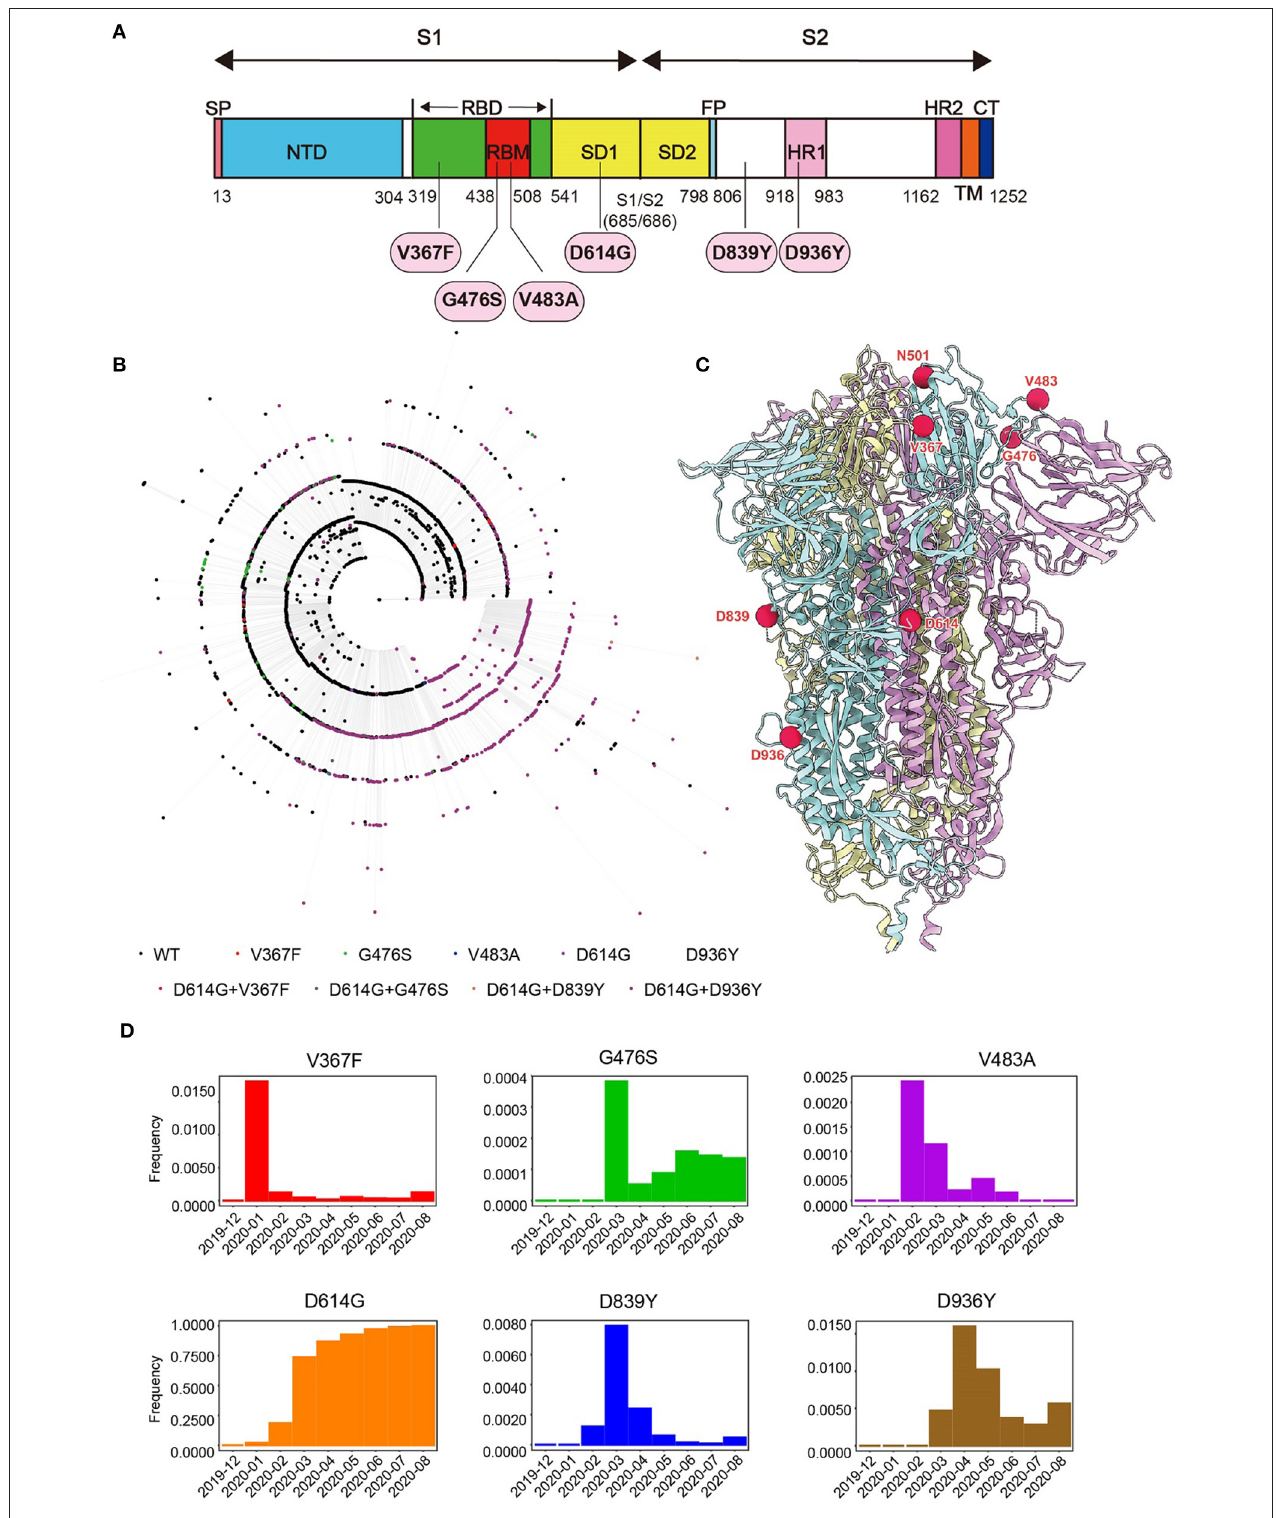
FIGURE 1 | Genome analysis of SARS-CoV-2. (A) Schematic diagram of SARS-CoV-2S protein. The mutations studied in the paper were marked. (B) Phylogenetic relationship between 4207 non-redundant SARS-CoV-2S gene sequences as of May 2020. Different colors of external nodes represent sequences carrying the corresponding mutations. (C) The mutations studied in the paper were highlighted in the Cryo-EM structure of SARS-CoV-2S trimer in pre-fusion conformation. Each S monomer is colored cyan, violet, or yellow. (D) Monthly frequencies of SARS-CoV-2 sequences carrying the corresponding mutations from December 2019 to August 2020 are demonstrated in the